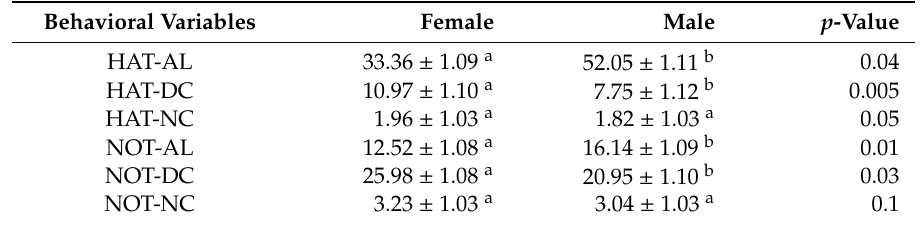
Table 1. Least squares means and standard errors (s) (retransformed) of the behavioral variables in the HAT and NOT of di ff erent genders.